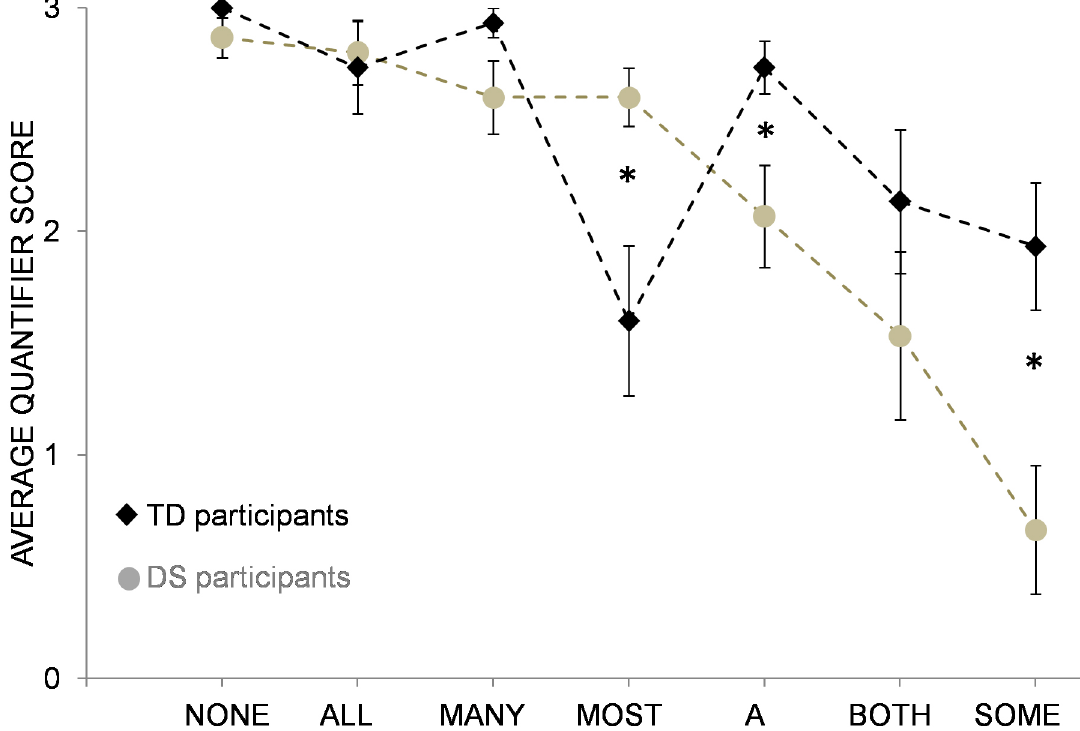
Fig 2. Comparison DS-TD. Average scores of participants with DS and TD children for individual quantifiers. Error bars represent standard errors of the mean.